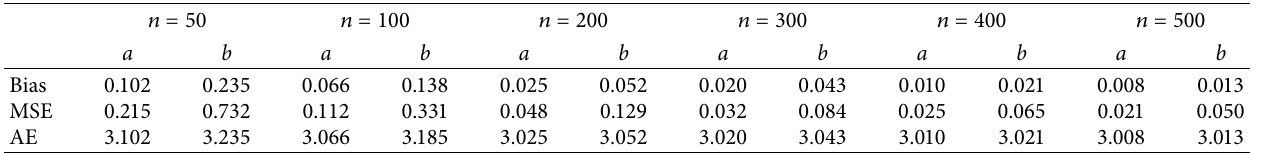
Table 6: Biases, MSEs, and AE for scenario-V.